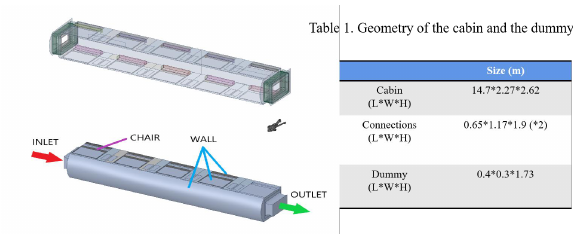
Figure 2 . The geometry of the vacant cabin and the dummy.